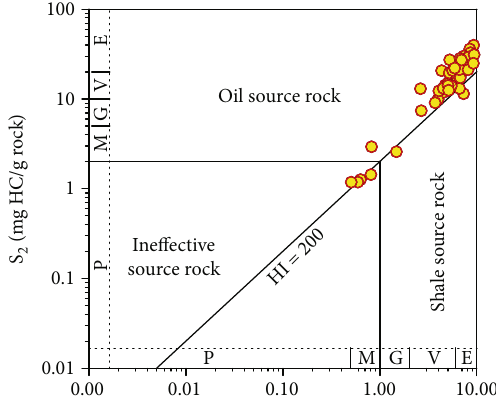
Figure 9: Discrimination diagram of S (TOC) for source rock evaluation [29]. Note that the P, M, G, V, and E represent the poor, moderate, good, very good, and excellent,